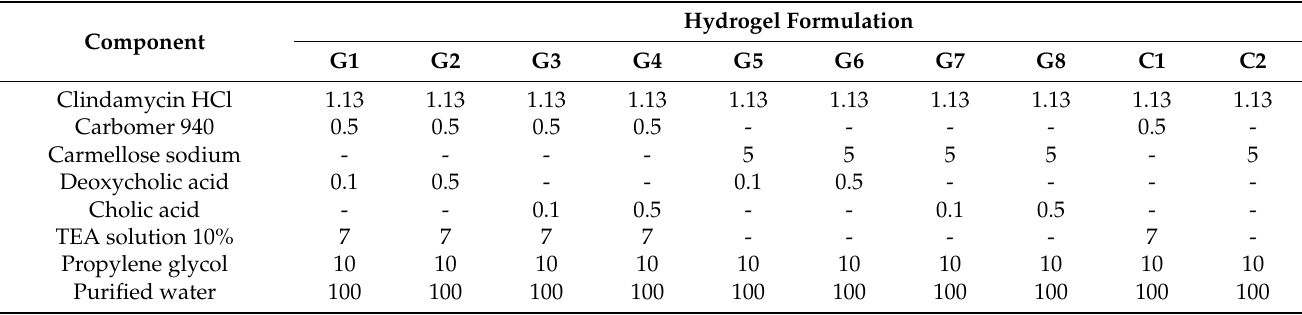
Table 6. Quantitative composition of hydrogel formulations (% wt / wt